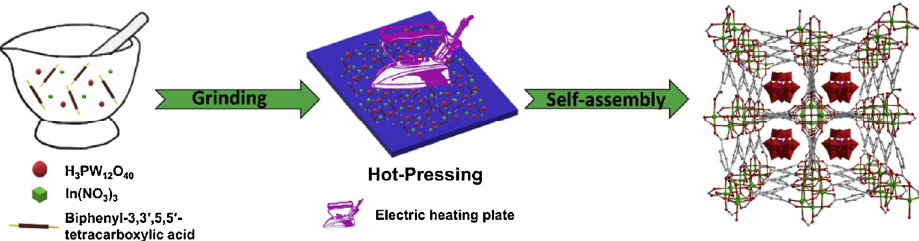
Figure 1. The hot-pressing synthesis process of PW 12 @MFM-300(In). Reprinted from [49]. Copyright (2019), with permission from Elsevier.